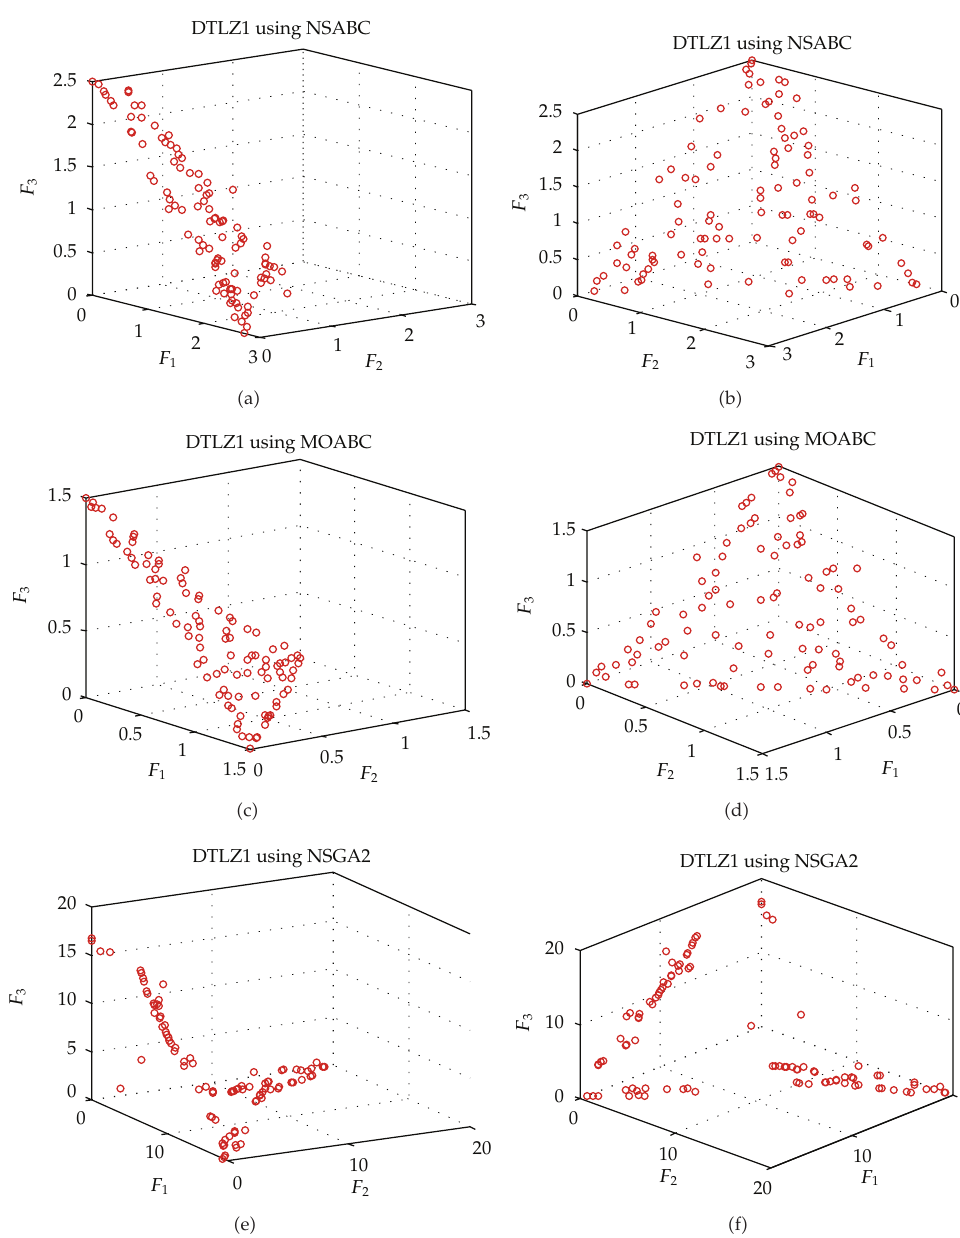
Figure 14: Pareto fronts obtained by NSABC, MOABC, and NSGA-II on DTLZ1 after 20000